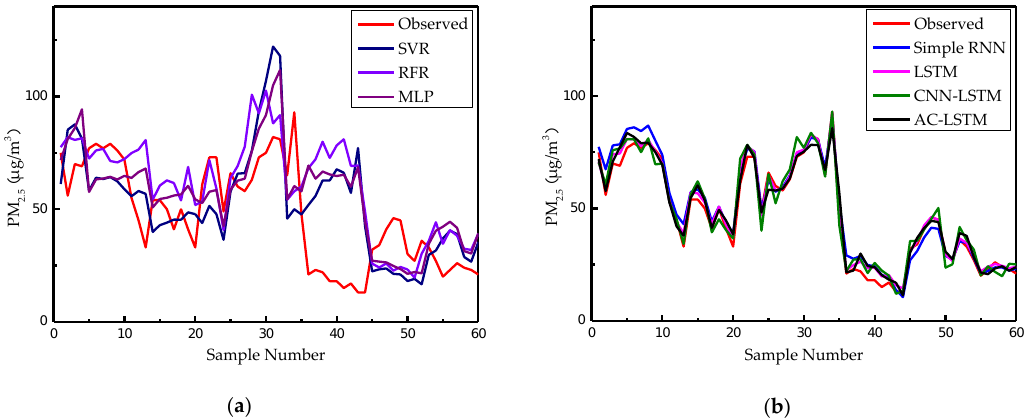
Figure A3. The results of all models in the 10-h PM 2.5 prediction: ( a ) SVR, RFR, and MLP; ( b ) simple RNN, LSTM, CNN–LSTM, and AC-LSTM.